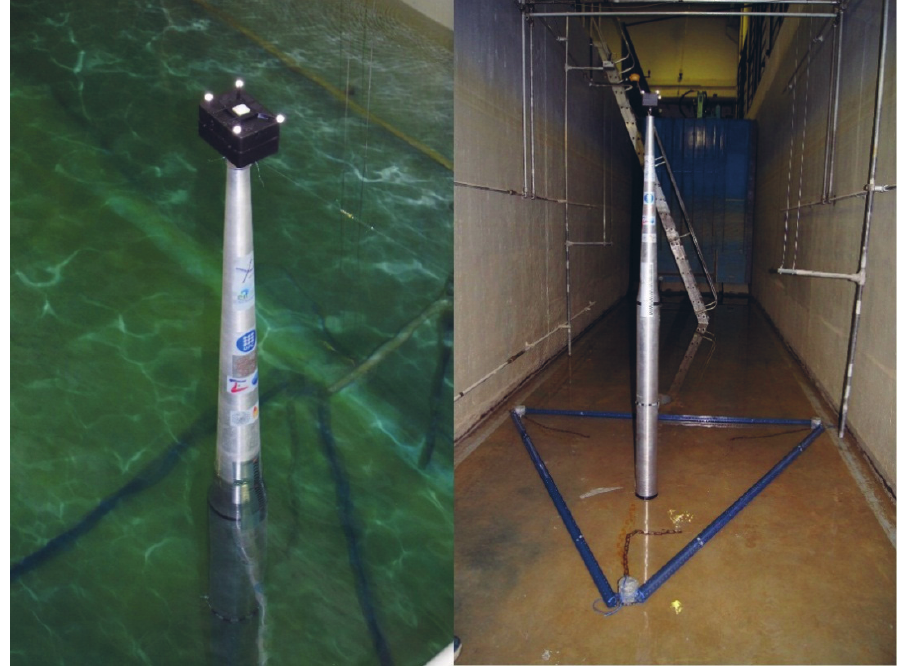
Figure 12. Scale model inside the